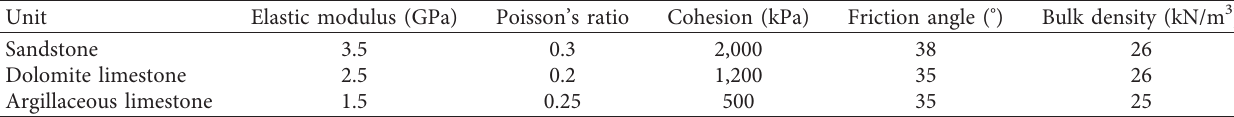
Table 1: Geotechnical parameters.